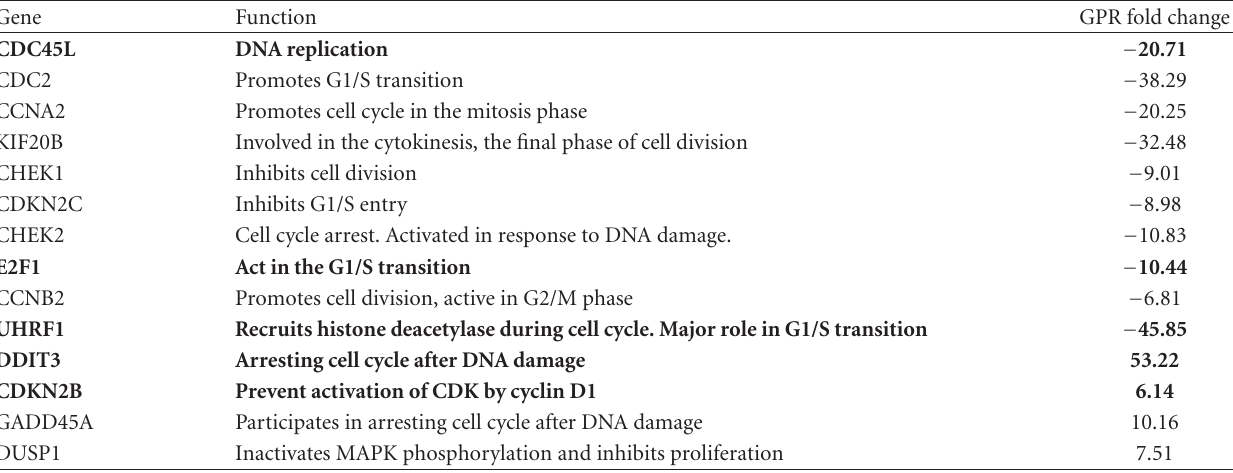
Table 4: Significant GPR fold change in the mRNA of target genes related to cell cycle in IGF-1 + auraptene treated cells compared to cells treated with IGF-1 alone at 24 h (the genes significantly changed at both 8 h and 24 h time points are shown in